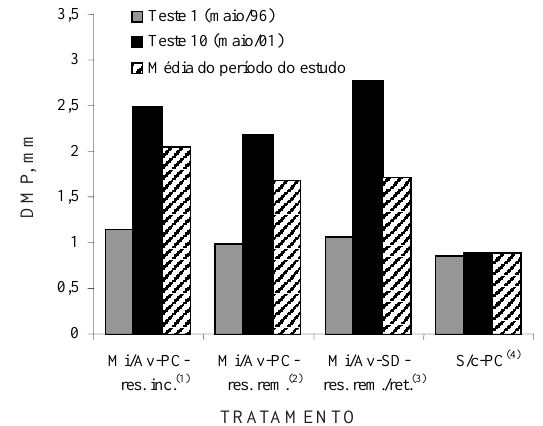
Figura 1. Valores do diâmetro médio